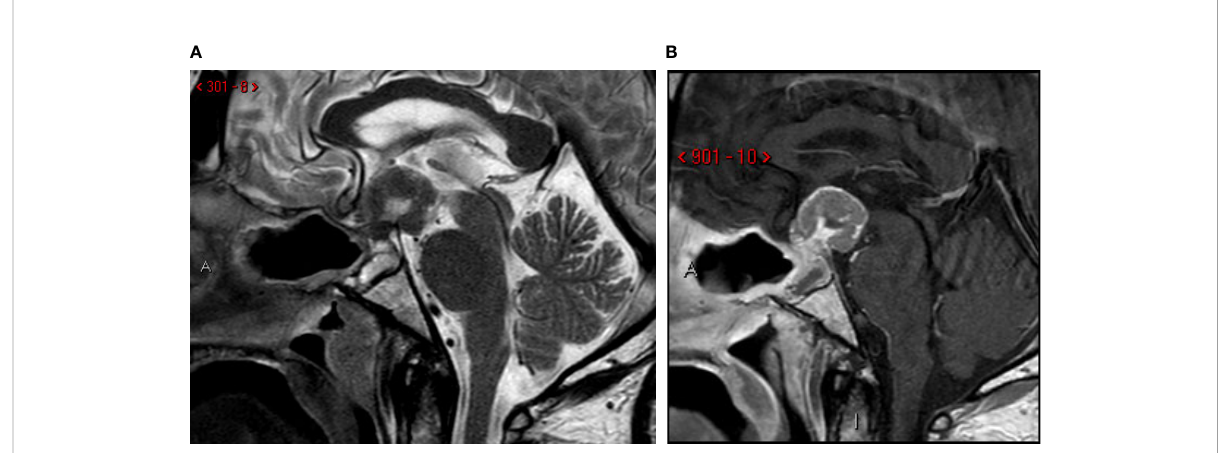
FIGURE 3 One-month follow-up MRI scan. Sagittal T2-weighted (A) and post-contrast T1-weighted (B) images. Post-surgical sellar modi fi cation with increase of the residual tumor in suprasellar spaces, third ventricle invasion and mammillary body compression and in fi ltration.